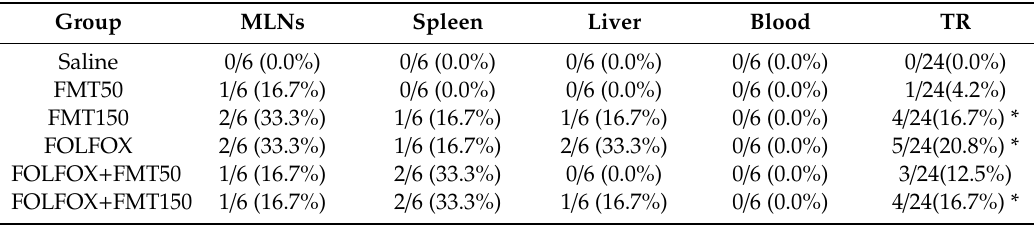
Table 2. Analysis of translocation of bacteria to the mesenteric lymph node, blood, liver, and spleen of